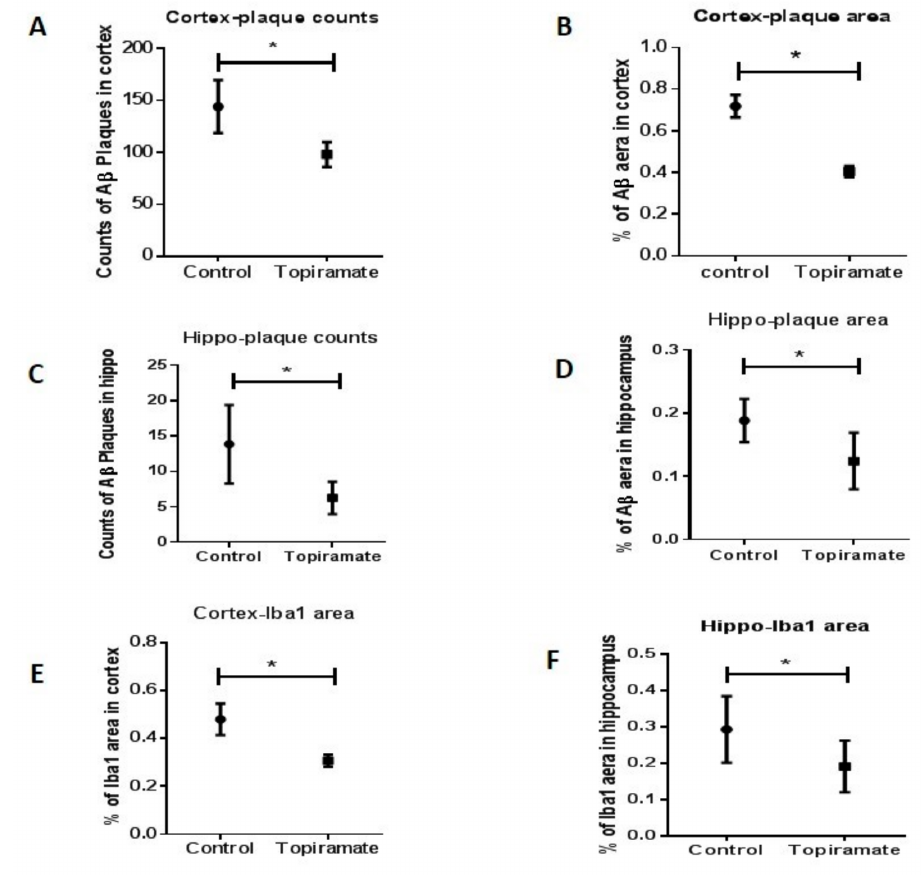
Figure 4. E ff ect of topiramate on β -amyloid deposition and microglial activation. APP / PS1 were either treated with topiramate or carboxymethylcellulose (CMC) (used as vehicle for control group). After 21 days of treatment by gavage, brains from transgenic mice and their untreated littermates were analyzed by immunohistochemistry. Cells and plaque count as well as arithmetic means of the immunoreactivity (IR) area are represented in di ff erent graphs. The unpaired t-test was used to calculate the di ff erences of plaque / cell counts and area percentages between the treatment group and control, with significance levels set at p < 0.05. ( A ) Topiramate significantly reduced the number of amyloid plaques in the cortex of APP / PS1. ( C ) A reduction of plaque number was also observed in the hippocampus of mice. ( B , D ) IR percentages of amyloid plaques were significantly reduced in both the hippocampus and cortex after topiramate treatment. ( E , F ) In APP / PS1 mice treated with topiramate, the Iba-1 IR was significantly reduced in both the cortex and